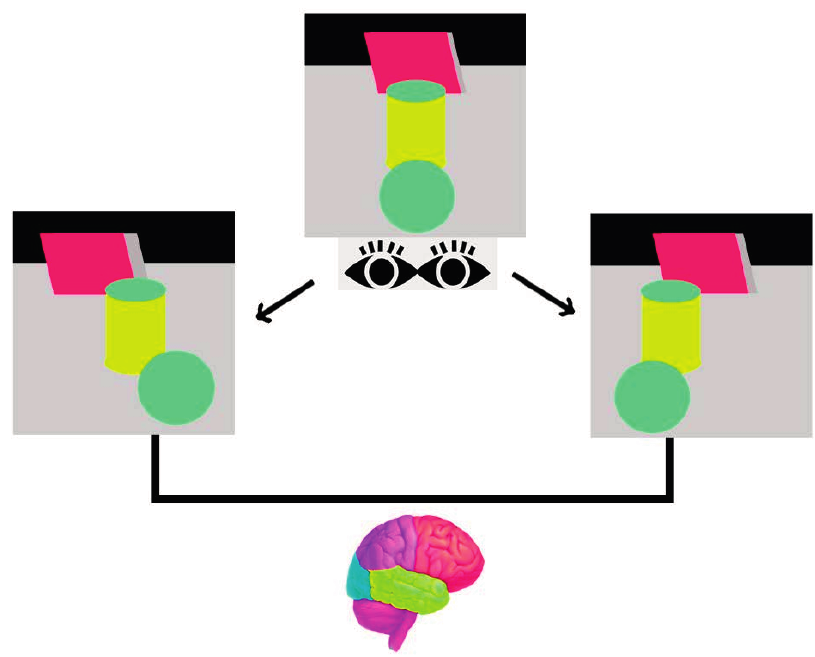
Figure 1. Two images sent to the brain to synthesize the stereoscopic effect.